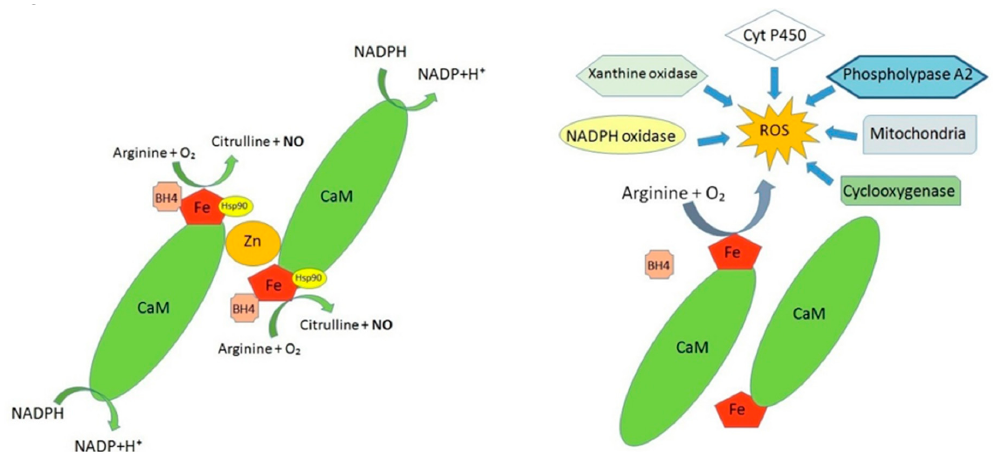
Figure 2. NOS activity. Under normal condition calcium is associates with calmodulin to activate the 192 enzyme eNOS which produces NO from its precursor L -arginine forming L -citrulline. In this context 193 the enzymatic reaction generating NO involves the transfer of electrons from NADPH, via the flavins 194 to the heme and consequently the substrate L -arginine is oxidized to L -citrulline and NO. To efficiently 195 produce NO, eNOS must effectively coordinate the binding of multiple substrates and cofactors such 196 as Tetrahydrobiopetrin (BH4). Disruption of this highly coordinated catalysis (uncoupled eNOS) can 197 result in the production of superoxide and peroxynitrite. Other sources of ROOS are mitochondria, 198 phospholipase A2, Cyclooxygenase, Cyt P450, xanthine oxidase, NADPH oxidase. 199 Moreover, in the production and release of NO from endothelium many agonists are involved; 200 among them, acetylcholine, histamine, thrombin, serotonin, bradykinin, substance P, isoproterenol, 201 and norepinephrine bind to specific receptors on the membrane of endothelial cells, resulting in a 202 rapid release of NO [36]. More specifically, the binding of the agonist receptor leads to an increase in 203 the concentration of cytosolic calcium released from the endoplasmic reticulum, with the subsequent 204 binding and activation of eNOS. In this scenario, the NO production is strictly dependent on the 205 amount of available calcium; in fact, at low concentrations the calcium-calmodulin complex 206 dissociates from the enzyme, causing its deactivation [37]. 207 The new synthesized NO leaves the endothelial cells and diffuses into adjacent smooth muscle 208 cells, where it stimulates the soluble guanylate cyclase (sGC) enzyme, involved in the increase of 209 cyclic guanosine monophosphate (cGMP). The accumulation of cGMP, in turn, reduces muscle 210 tension on one side and, on the other, minimizes the release of calcium ions from the endoplasmic 211 reticulum. The combination of these two effects decreases the contraction of smooth muscle cells and, 212 therefore, leads to vasodilation; finally, cGMP effect can be restored or neutralized by the action of 213